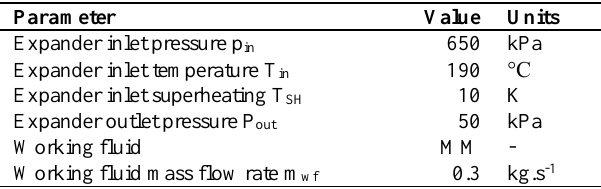
Table 1. Turboexpander design boundary conditions defined by the cycle